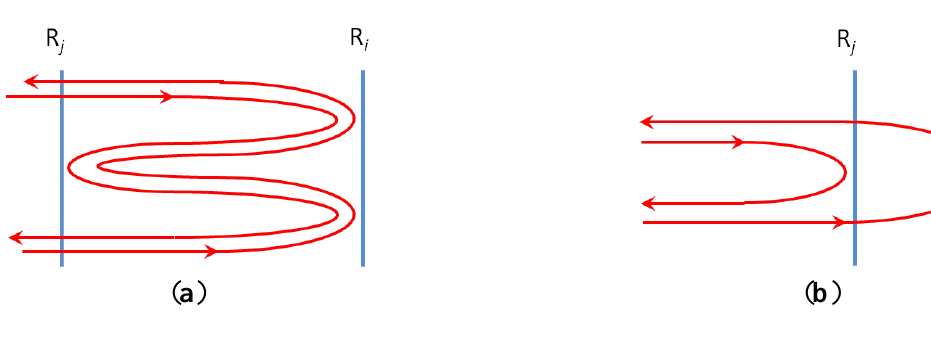
Figure 12. The effects of unwanted reflections. ( a ) Multiple reflections between a pair of sensors. ( b ) Interference between lightwaves reflected by different